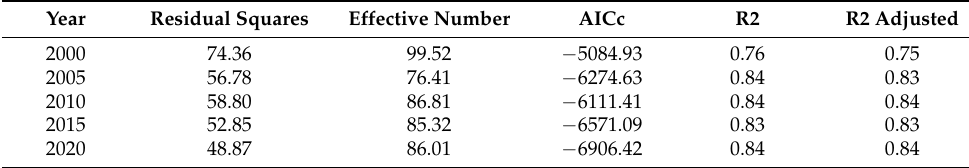
Table 7. Estimated parameters of the GWR